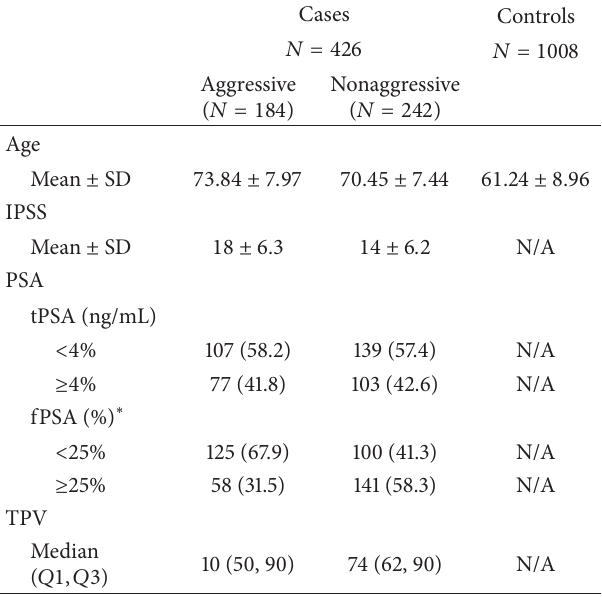
Table 1: The clinical characteristics of all